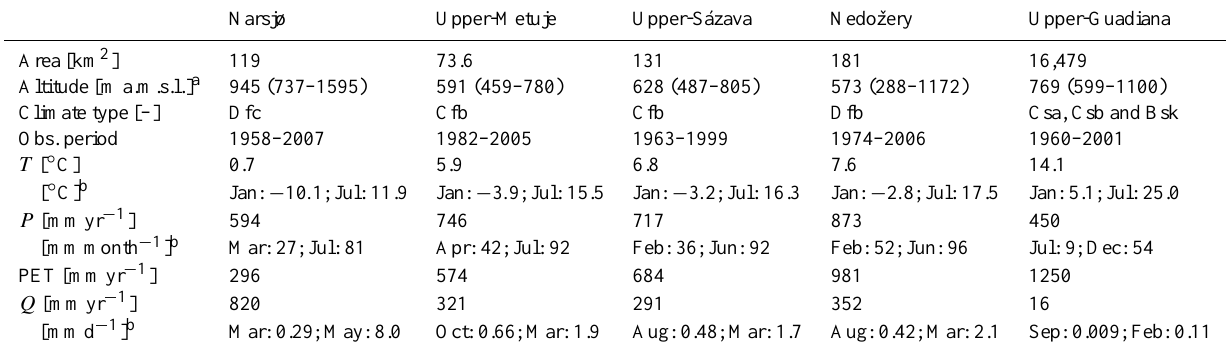
Table 1. Catchment characteristics of the selected catchments Narsjø (Norway), Upper-Metuje and Upper-S´azava (Czech Republic), Nedoˇzery (Slovakia), and Upper-Guadiana (Spain); obs. period = observation period, T = temperature, P = precipitation, PET = potential evaporation, Q = discharge. Narsjø Upper-Metuje Upper-S´azava Nedoˇzery